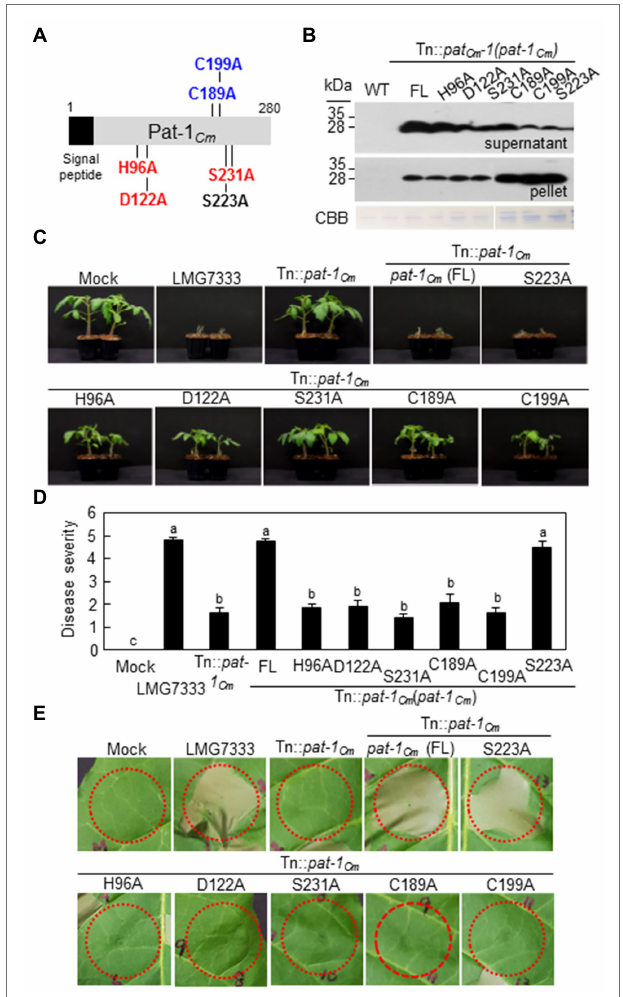
FIGURE 6 | Key amino acids in the Pat-1 Cm protein for both pathogenicity and HR-eliciting activities of Clavibacter michiganensis . (A) Schematic of amino acid substitutions in the Pat-1 Cm protein. Variants with catalytic triad replacements (H96A, D122A, and S231A) and disulfide bond replacements (C189A and C199A) are shown in red and blue, respectively. Variant S222A was randomly selected as a control. (B) Expression and secretion of Pat-1 Cm and its variants in the indicated strains. All proteins were fused to FLAG on their C-termini and expressed in Tn:: pat-1 Cm strains. Total proteins from supernatant and pellet were analyzed by immunoblot using anti-FLAG antibody. CBB, Coomassie Brilliant Blue. (C) Wilting symptom development in tomato plants inoculated with C. michiganensis Tn:: pat-1 Cm strain carrying diverse variants of the full length (FL) pat-1 Cm gene. Two-week-old plants were inoculated and were photographed 14 dai. (D) Disease severity of wilting in tomato plants inoculated with the indicated strains 14 dai. Error bars indicate SE ( n = 10). Nonparametric Kruskal–Wallis test with Dunnett’s multiple comparisons ( p < 0.05) was used to analyze the level of disease severity in tomato plants, and different letters indicate statistically significant differences at p < 0.05. (E) HR phenotype in Nicotiana tabacum after infiltration with indicated strains. Five-week-old plant leaves were inoculated, and representative leaves were photographed 36 h after infiltration. Red dotted lines indicate infiltrated regions. Mock, 10 mM MgCl 2 ; FL, full length pat-1